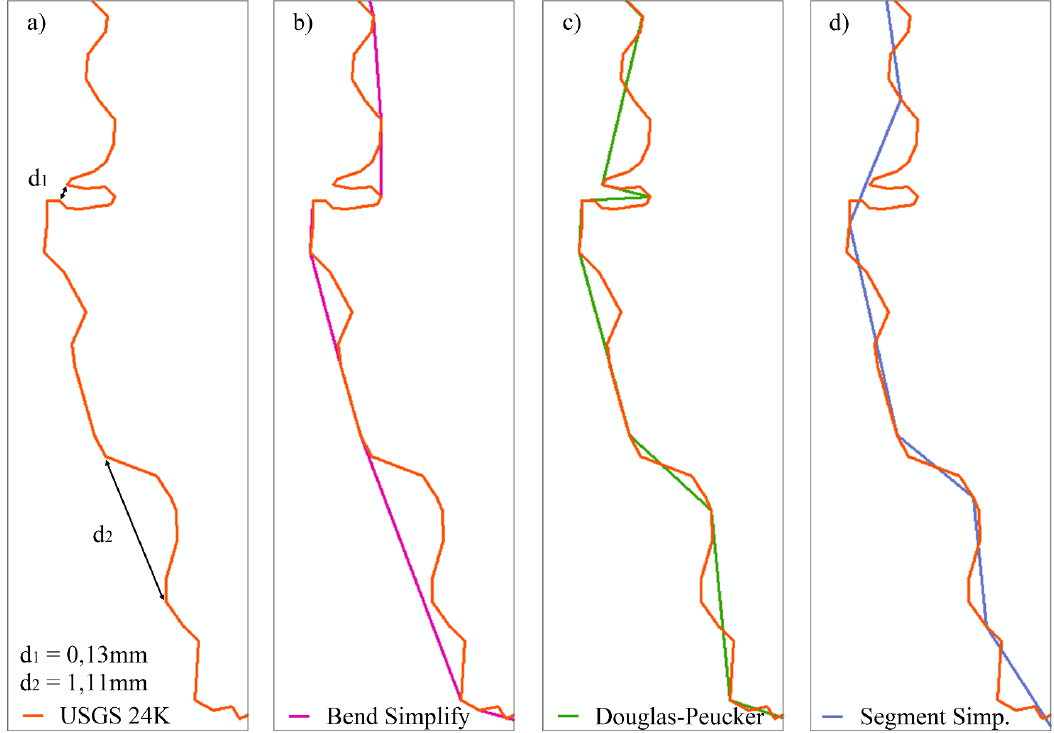
Figure 13. Behaviors of the algorithms at several bends. ( a ) An original stream. ( b ) Bend Simplify (Tolerance: 150m). ( c ) Douglas-Peucker (Tolerance: 25.4m). ( d ) Segment Simplify (Error band: